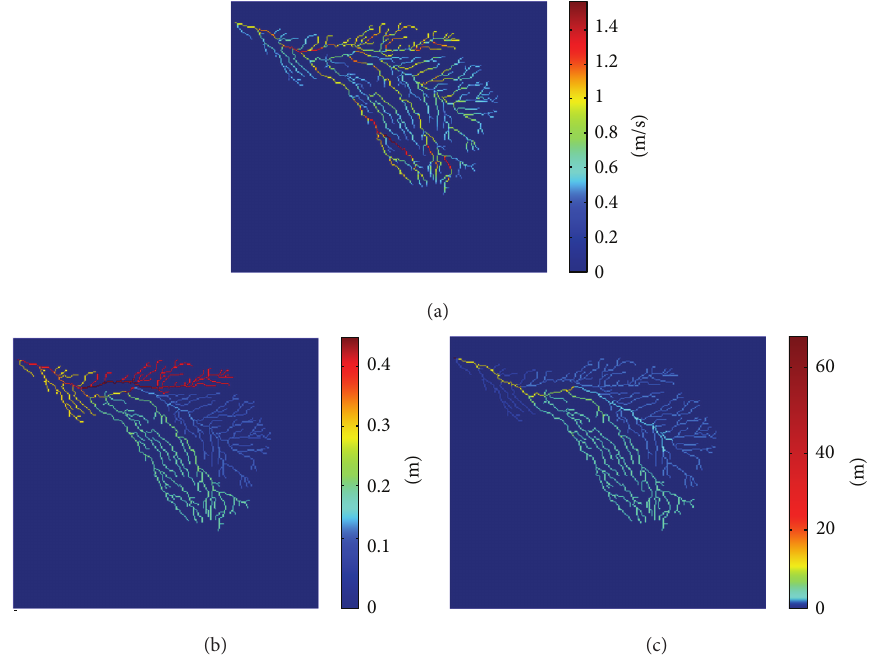
Figure 3: Global pattern of (a) flow velocity, (b) water level, and (c) width. In these figures we set to zero all the corresponding values outside the river channels.